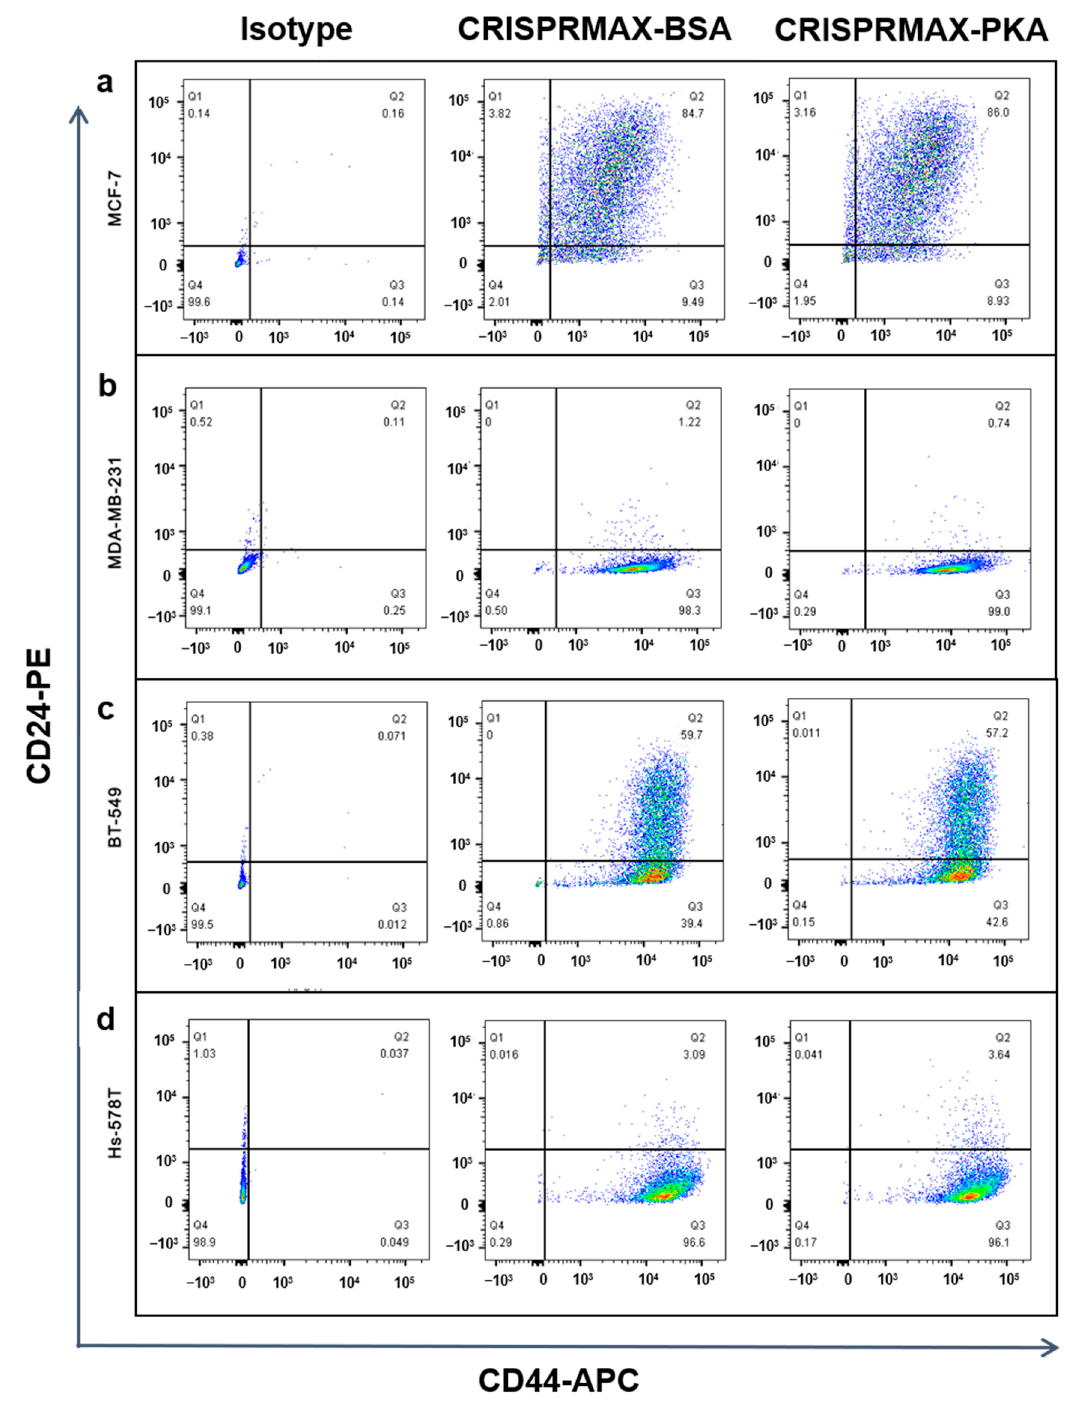
Figure 5. FCM analysis of the CD44 + /CD24 − population in breast cancer cells after introducing CRISPRMAX-PKAs or CRISPRMAX-BSAs. ( a ) MCF-7 cells; ( b ) MDA-MB-231 cells; ( c ) BT-549 cells; ( d ) Hs-578T cells. The CD44 + /CD24 − antigenic phenotype was shown in the Q3 area (at the right lower corner of the individual image). For isotype group: cells transfected with ddH 2 O through CRISPRMAX as controls were incubated with the same amount of APC-isotype IgG and PE-isotype IgG with CD44-APC and CD24-PE antibodies; as for the BSA and PKA groups, the cells transfected with BSAs or PKAs were incubated with CD44-APC and CD24-PE antibodies. X -axis presents CD44-APC of the cells; Y -axis shows CD24-PE of the cells. All cells were delivered with PKAs or BSAs for 3 to 5 days. FCM, flow cytometry.